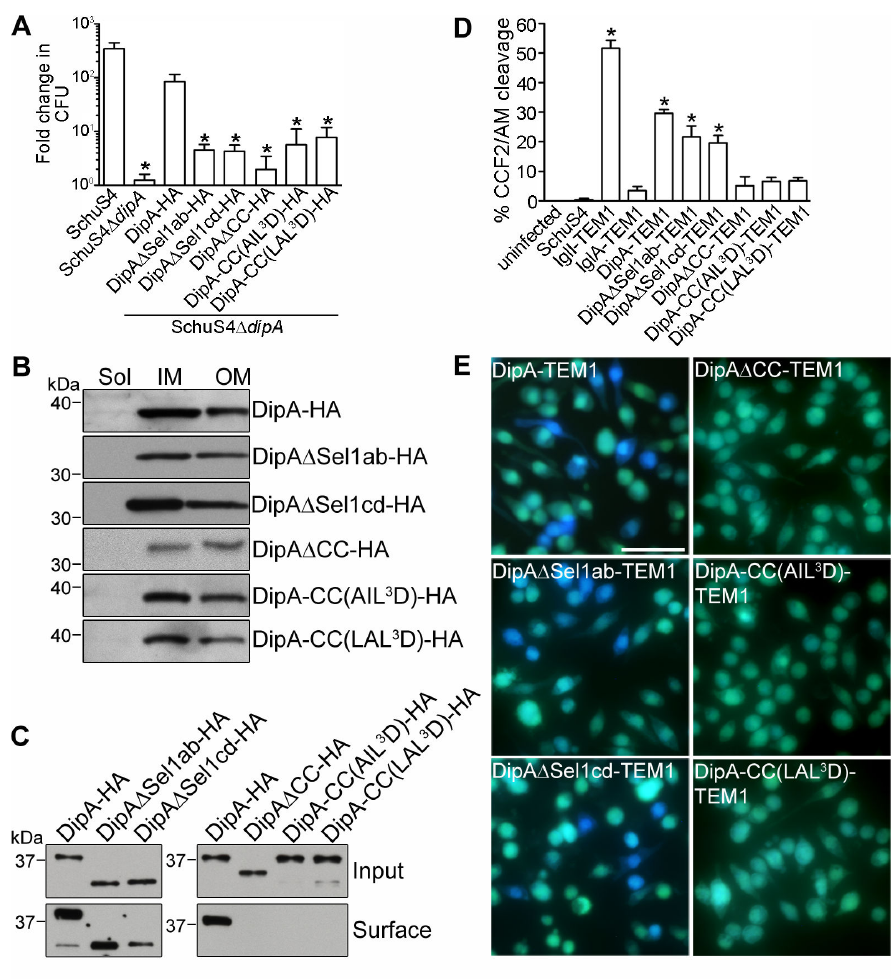
Figure 4. The SLR and CC domains of DipA are functionally distinct. (A) Ability of DipA variants to complement the intracellular growth defect of SchuS4Δ dipA . Viable intracellular bacteria were enumerated at 1 h and 16 h p.i. from BMMs infected with SchuS4, SchuS4Δ dipA , or SchuS4Δ dipA expressing HA-tagged DipA variants (DipA-HA, DipAΔSel1ab-HA, DipAΔSel1cd-HA, DipAΔCC-HA, DipACC(AIL 3 D)-HA, or DipACC(LAL 3 D)-HA). Fold change in replication was calculated by comparing CFUs at 16 h p.i. versus 1 h p.i. Data are means ± SD from three independent experiments. Asterisks indicate statistically significant differences compared to SchuS4-infected and SchuS4Δ dipA expressing DipA-HA-infected macrophages (* P < 0.05 , 1-way ANOVA, Tukey’s post-test). (B) Subcellular localization of HA-tagged DipA variants as described in (A). Soluble (Sol), inner membrane (IM), and outer membrane (OM) enriched fractions were separated based on Sarkosyl solubility and subjected to immunoblot analysis with antibodies against HA. Each fraction was concentrated to the same volume and equal volumes were loaded. (C) Immunoblot analysis of purified surface biotinylated proteins from lysates of SchuS4Δ dipA strains expressing HA-tagged DipA variants as described in (A). Input and biotinylated (surface) samples were processed for CFU enumeration and immunoblotting as described in Materials and Methods. Samples were loaded based on CFU equivalents as follows: 1x10 6 (Input) or 1x10 8 (surface). (D) Quantification of J774A.1 cells emitting blue fluorescence that were either uninfected or infected with SchuS4, or SchuS4 expressing C-terminal TEM1 fusions with IglI, IglA, DipA, DipAΔSel1ab, DipAΔSel1cd, DipAΔCC, DipACC(AIL 3 D), or DipACC(LAL 3 D). Infected cells were analyzed for CCF2/AM cleavage at 16 h pi. At least 100 cells were scored per experiment. Data are means ± SD from a representative experiment performed in triplicate out of three independent repeats. Asterisks indicate statistically significant differences compared to uninfected, SchuS4-infected, and SchuS4 expressing IglA-TEM1-infected controls (* P < 0.001 , 1-way ANOVA, Tukey’s post-test). (E) Representative fluorescence micrographs of J774A.1 macrophages infected for 16 h with SchuS4 expressing either DipA-TEM1, DipAΔSel1ab-TEM1, DipAΔSel1cd-TEM1, DipAΔCC-TEM1, DipACC(AIL 3 D)-TEM1, or DipACC(LAL 3 D)-TEM1. Cells emitting blue fluorescence indicate delivery of TEM1 β-lactamase fusions to the cytosol to cleave the CCF2/AM substrate. Intact CCF2/AM, indicating the absence of TEM1 β-lactamase activity in the cytosol, results in green fluorescence emission. Scale bar, 50 µm. doi: 10.1371/journal.pone.0067965.g004 PLOS ONE |